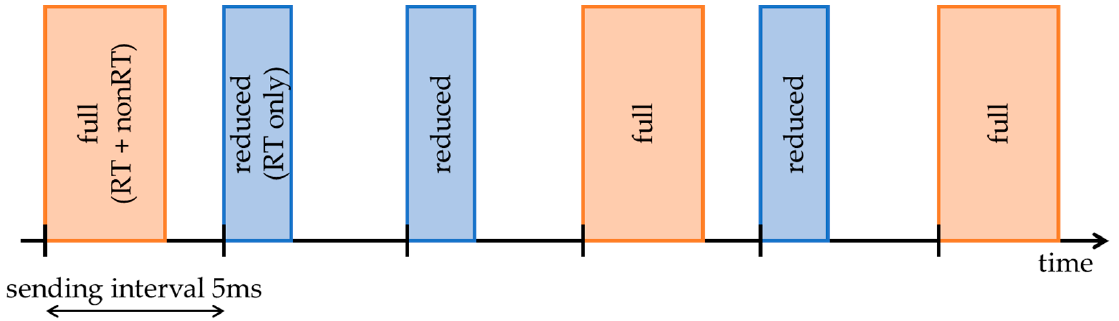
Table 4. Data from the gateway module to the controller.